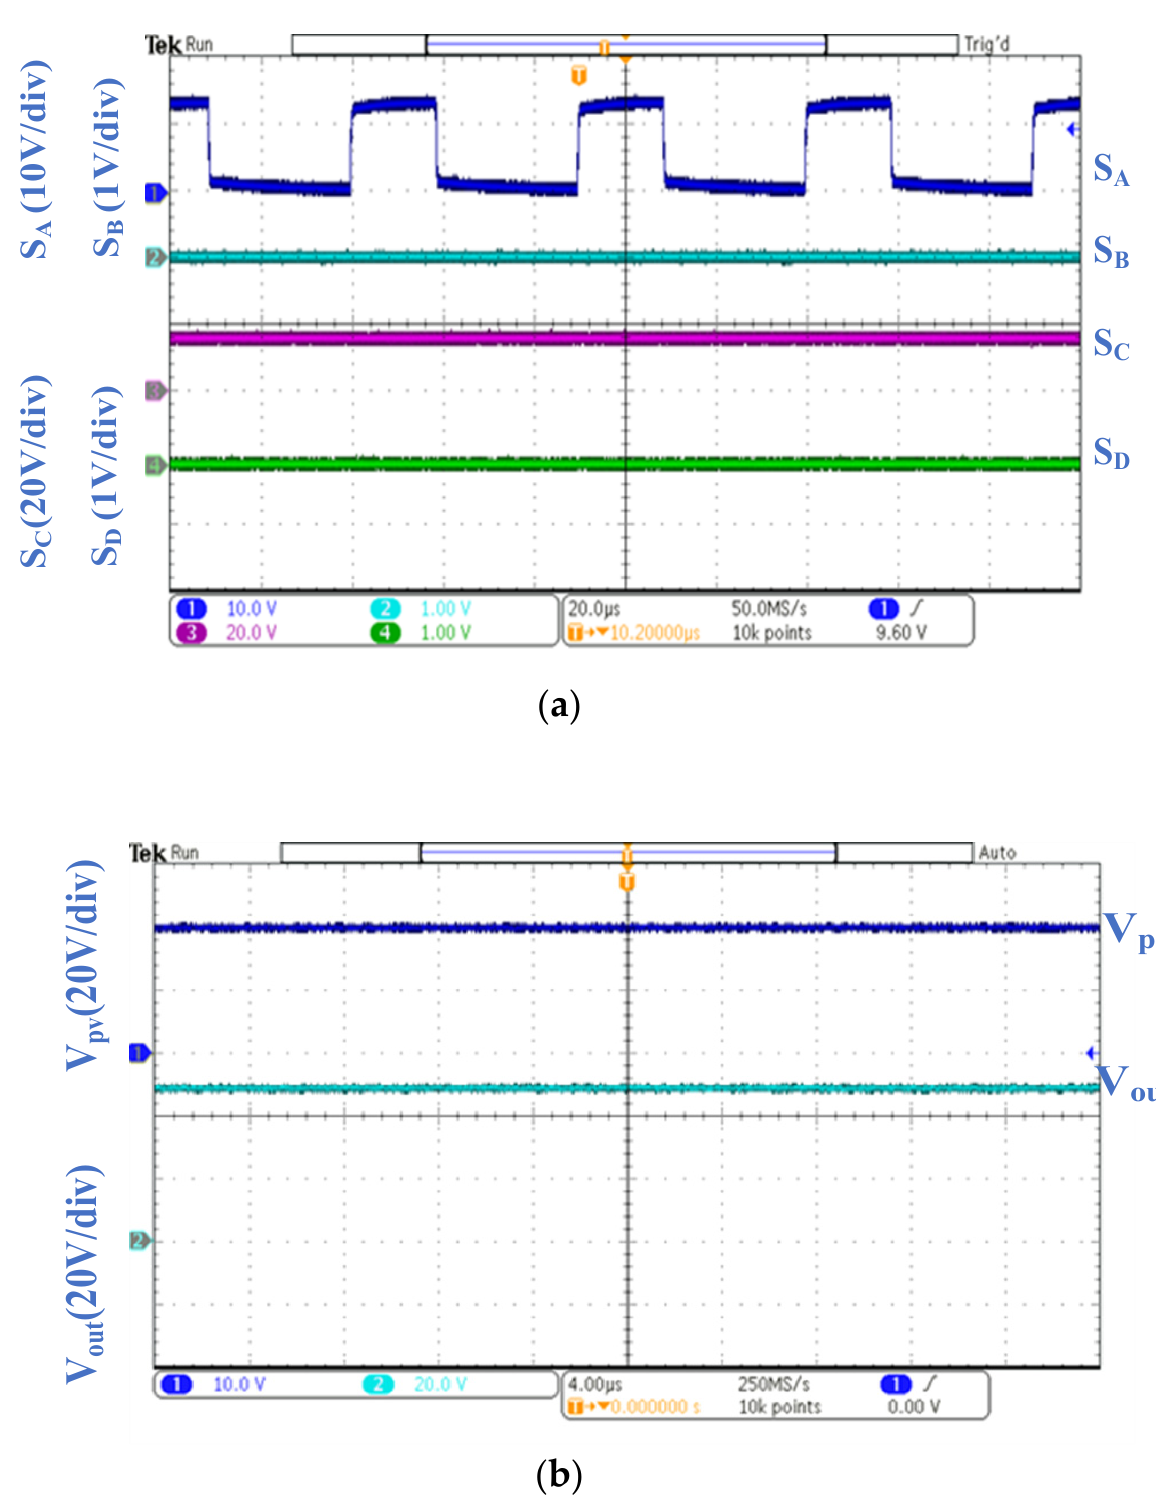
Figure 13. Experimental waveforms of the proposed IIABB converter for V pv of 40 V and N = 2: ( a ) experimental waveforms of switches S A and S C are operating; S B and S D are not operating; and ( b ) waveforms of V pv = 40 V and output voltage V out = 48 V via an intelligent control strategy and HC MPPT algorithm at a duty cycle of 0.38.